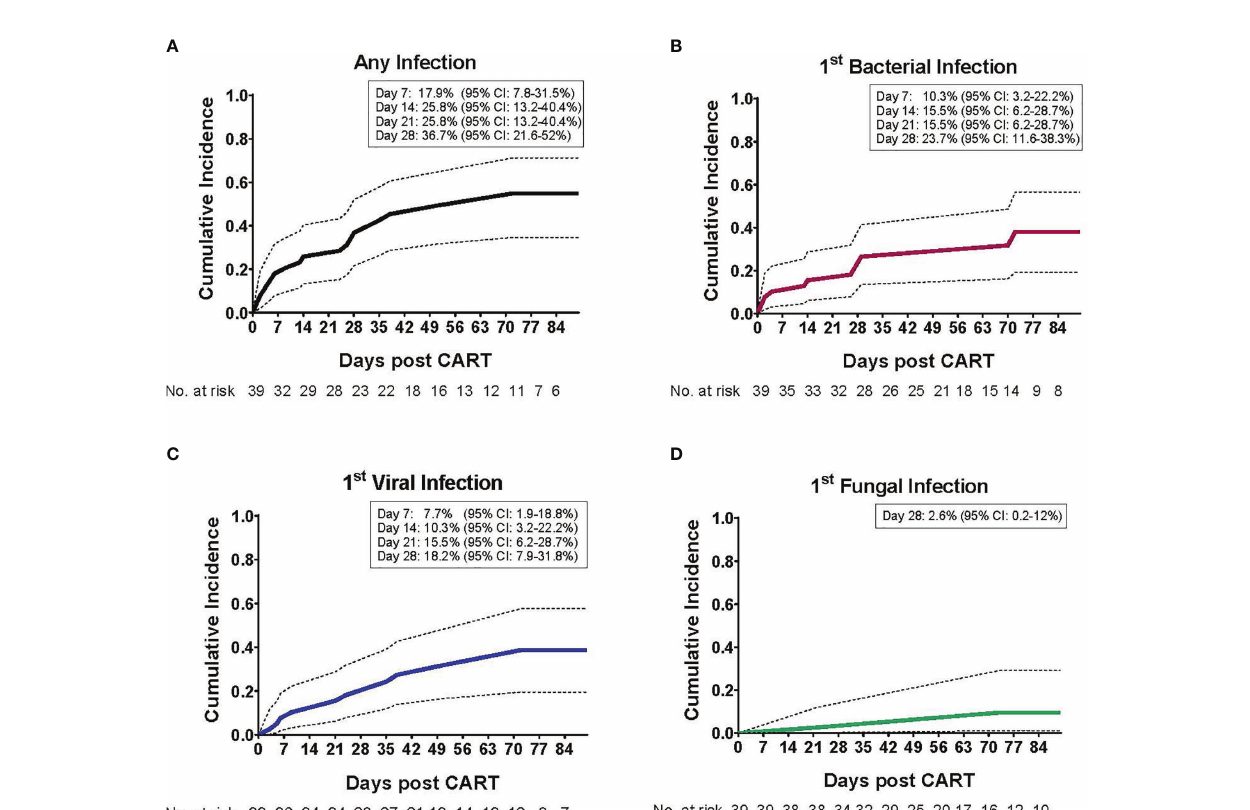
FIGURE 1 | Cumulative incidence of infections post CD19-CAR T cell therapy in pediatric and AYA patients. The cumulative incidence (CI) of infection post CD19- CAR T cell therapy, as a function of the day of infection onset, is depicted for the entire study period (day 1 – 90). (A) The cumulative incidence of fi rst infection, such that each patient may contribute only once (either bacterial, viral and/or fungal infection, whichever occurred fi rst). Most patients (73.7%) experienced their fi rst infection within the initial 28 days post CAR T cells, with a 36.7% CI (95% con fi dence interval: 21.6 - 52). The cumulative incidence of fi rst (B) bacterial infection, with a 23.7% CI (95% con fi dence interval: 11.6 – 38.3), (C) viral infection, with a 18.2% CI (95% con fi dence interval: 7.9 – 31.8), and (D) fungal infection, with a 2.6% CI (95% con fi dence interval: 0.2 – 12), by day 28 post CAR T cell